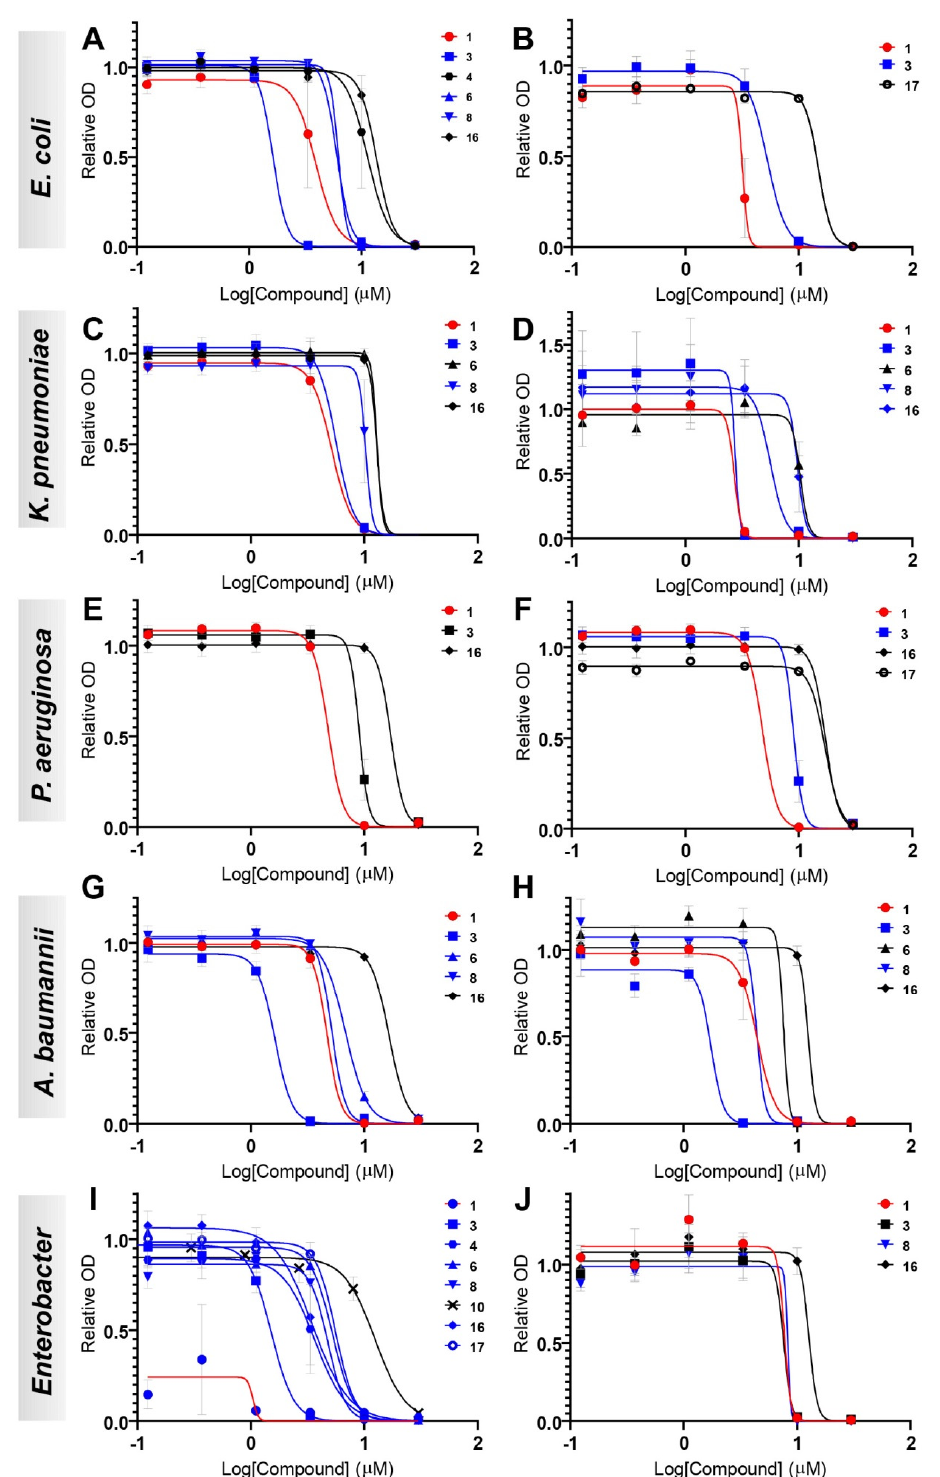
Figure 3. Antibacterial activity dose–response curves of compounds showing the most promising antimicrobial effects against the 10 Gram-negative bacteria, E. coli CCUG #17620/ATCC #25922 (control strain) ( A ) and CCUG #67180 ( B ), K. pneumoniae CCUG #58547 ( C ) and CCUG #225T ( D ), P. aeruginosa CCUG #17619 ( E ) and CCUG #59347 ( F ), A. baumannii CCUG #57035 ( G ) and CCUG #57250 ( H ), E. cloacae CCUG #6323T ( I ) and E. hormaechei CCUG #58962 ( J ). Compounds with the highest selectivity indices (SI ≥ 20 × ) are shown in blue and the lead compound in red. EC 50 , EC 90 and SI values (in µ M) can be found in Tables 2 and